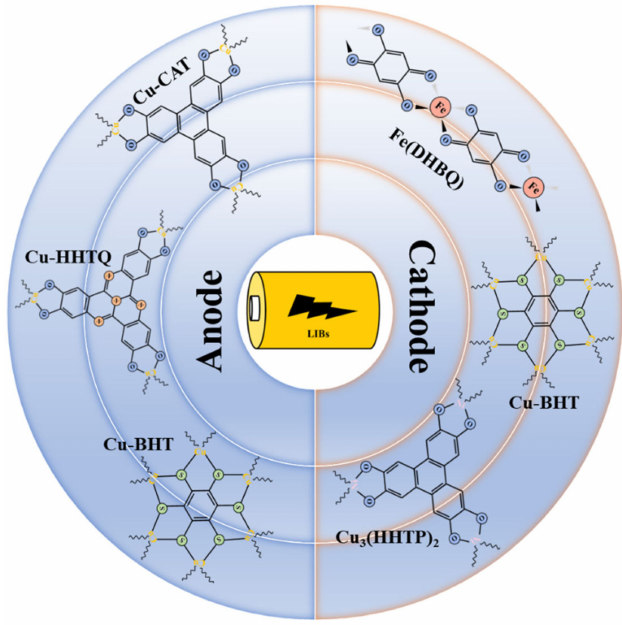
Figure 6. Application of c-MOFs in